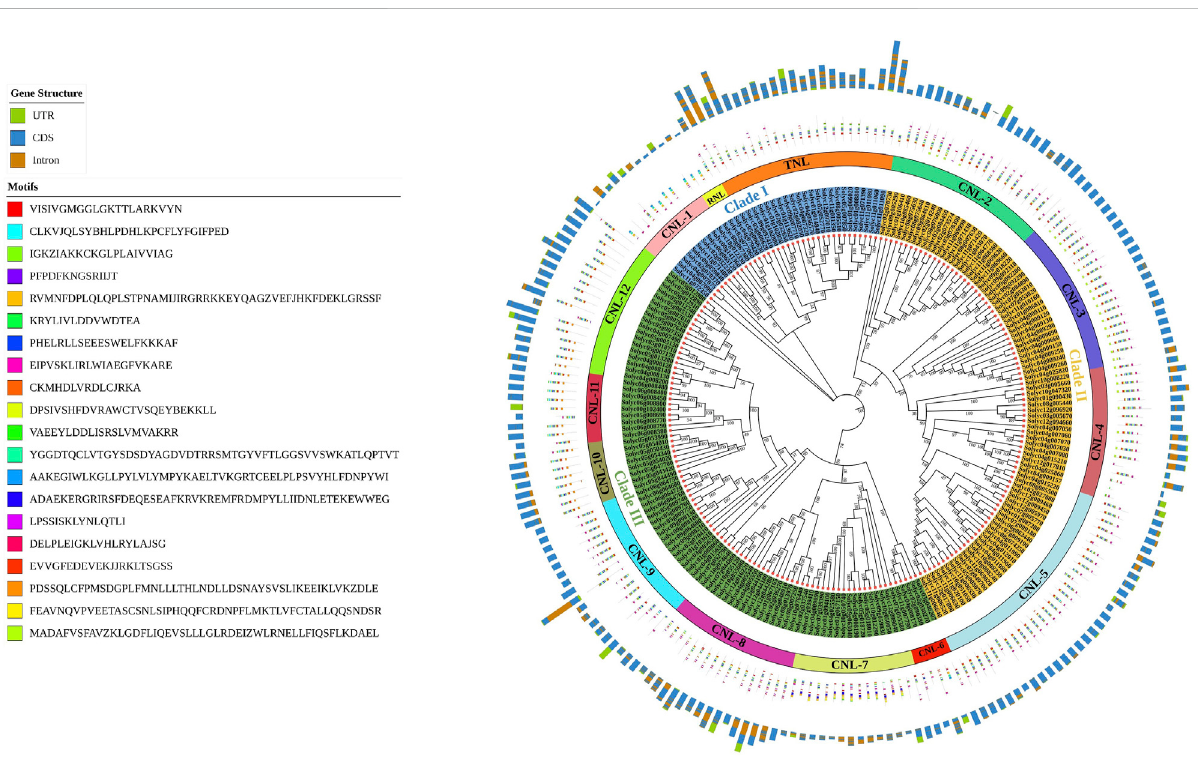
FIGURE 2 Phylogenetic tree within the tomato genome constructed using MEGAX and the maximum likelihood (ML) method with bootstrap replications after MSA in CLUSTALW. The evolutionary relationships among NLR genes containing full-length domains (three-sub families; CNL, TNL, and